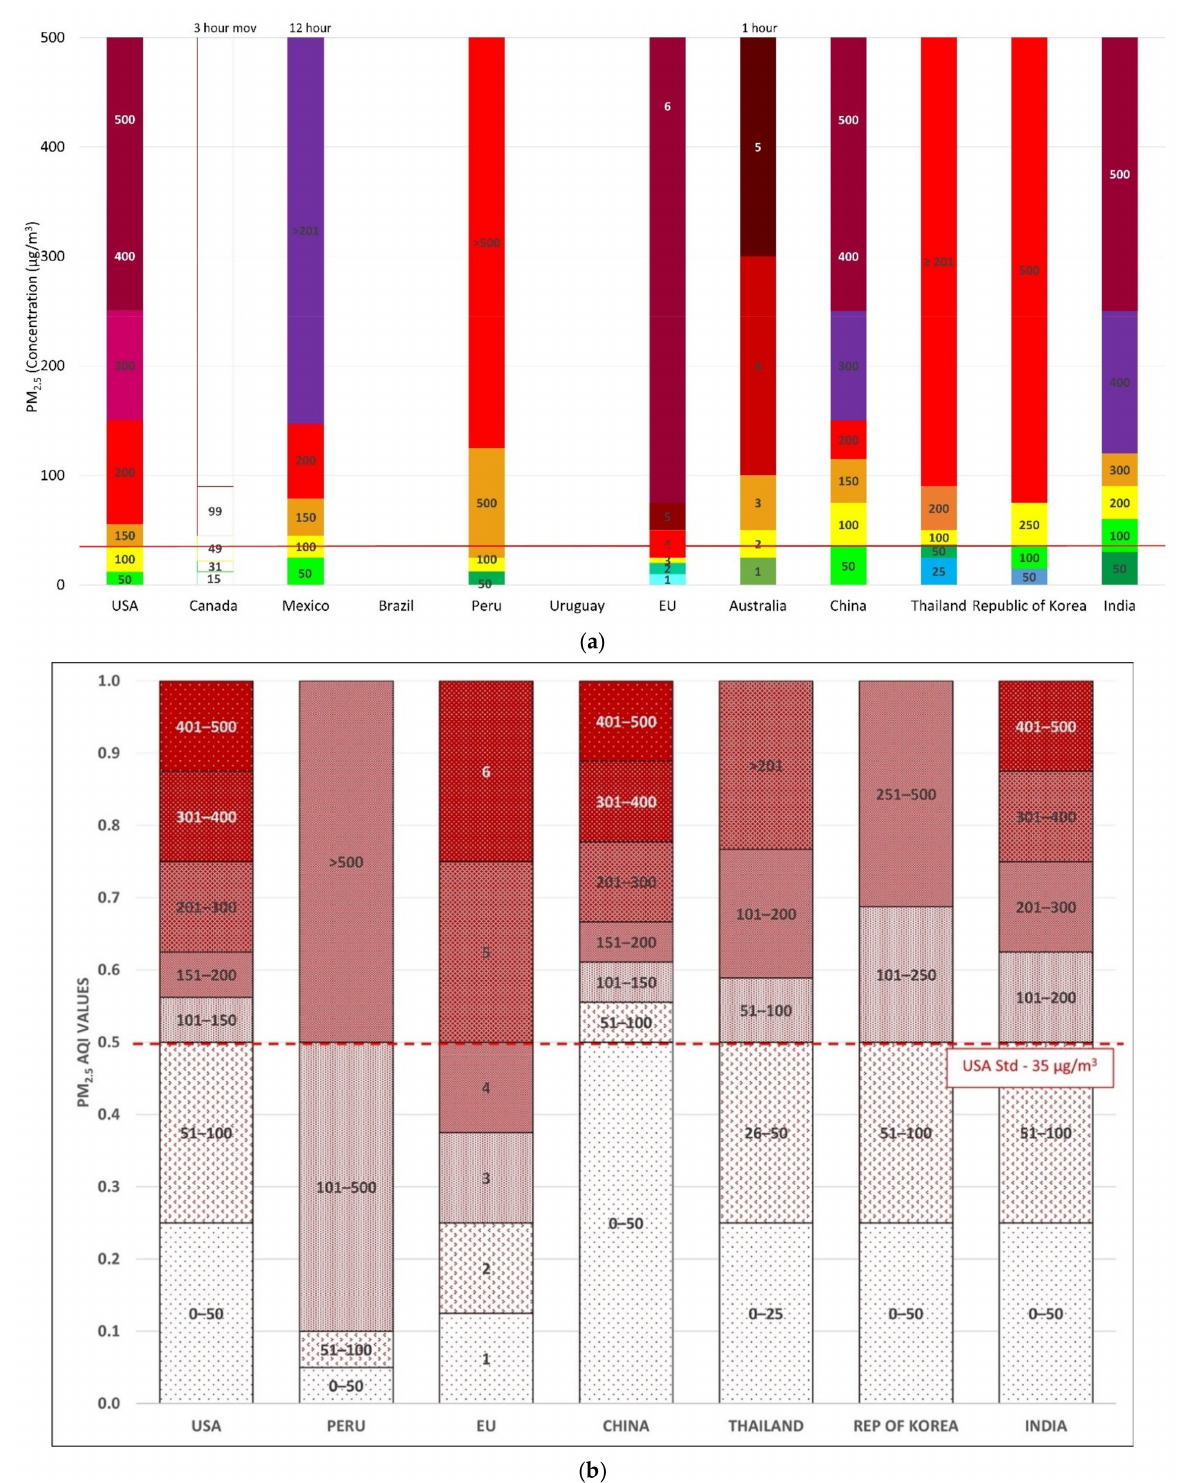
Figure 4. ( a ) PM 2.5 concentration associated with AQI classes in different countries (above the bars, the averaging periods when different from 24 h). The red line represents the USA standard value. ( b ) Normalized PM 2.5 AQI values (based on 24-h averaged